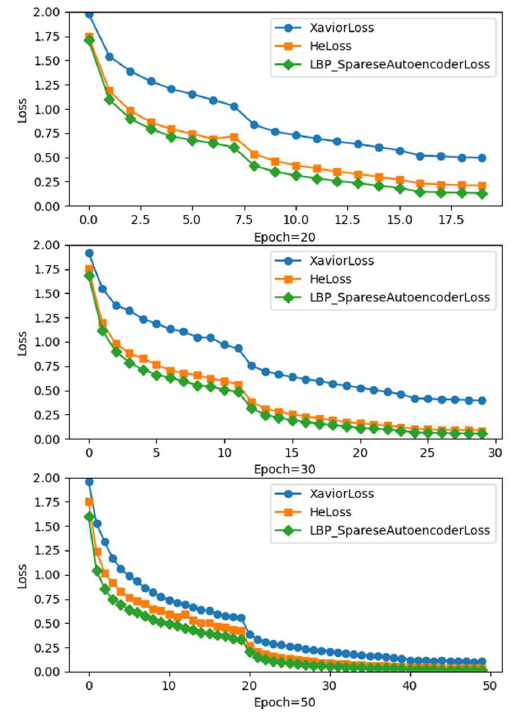
Figure 9. The comparison of CNN loss of three initialization methods with different iteration times. Table 3. The comparison of the recognition rate of three initialization methods.